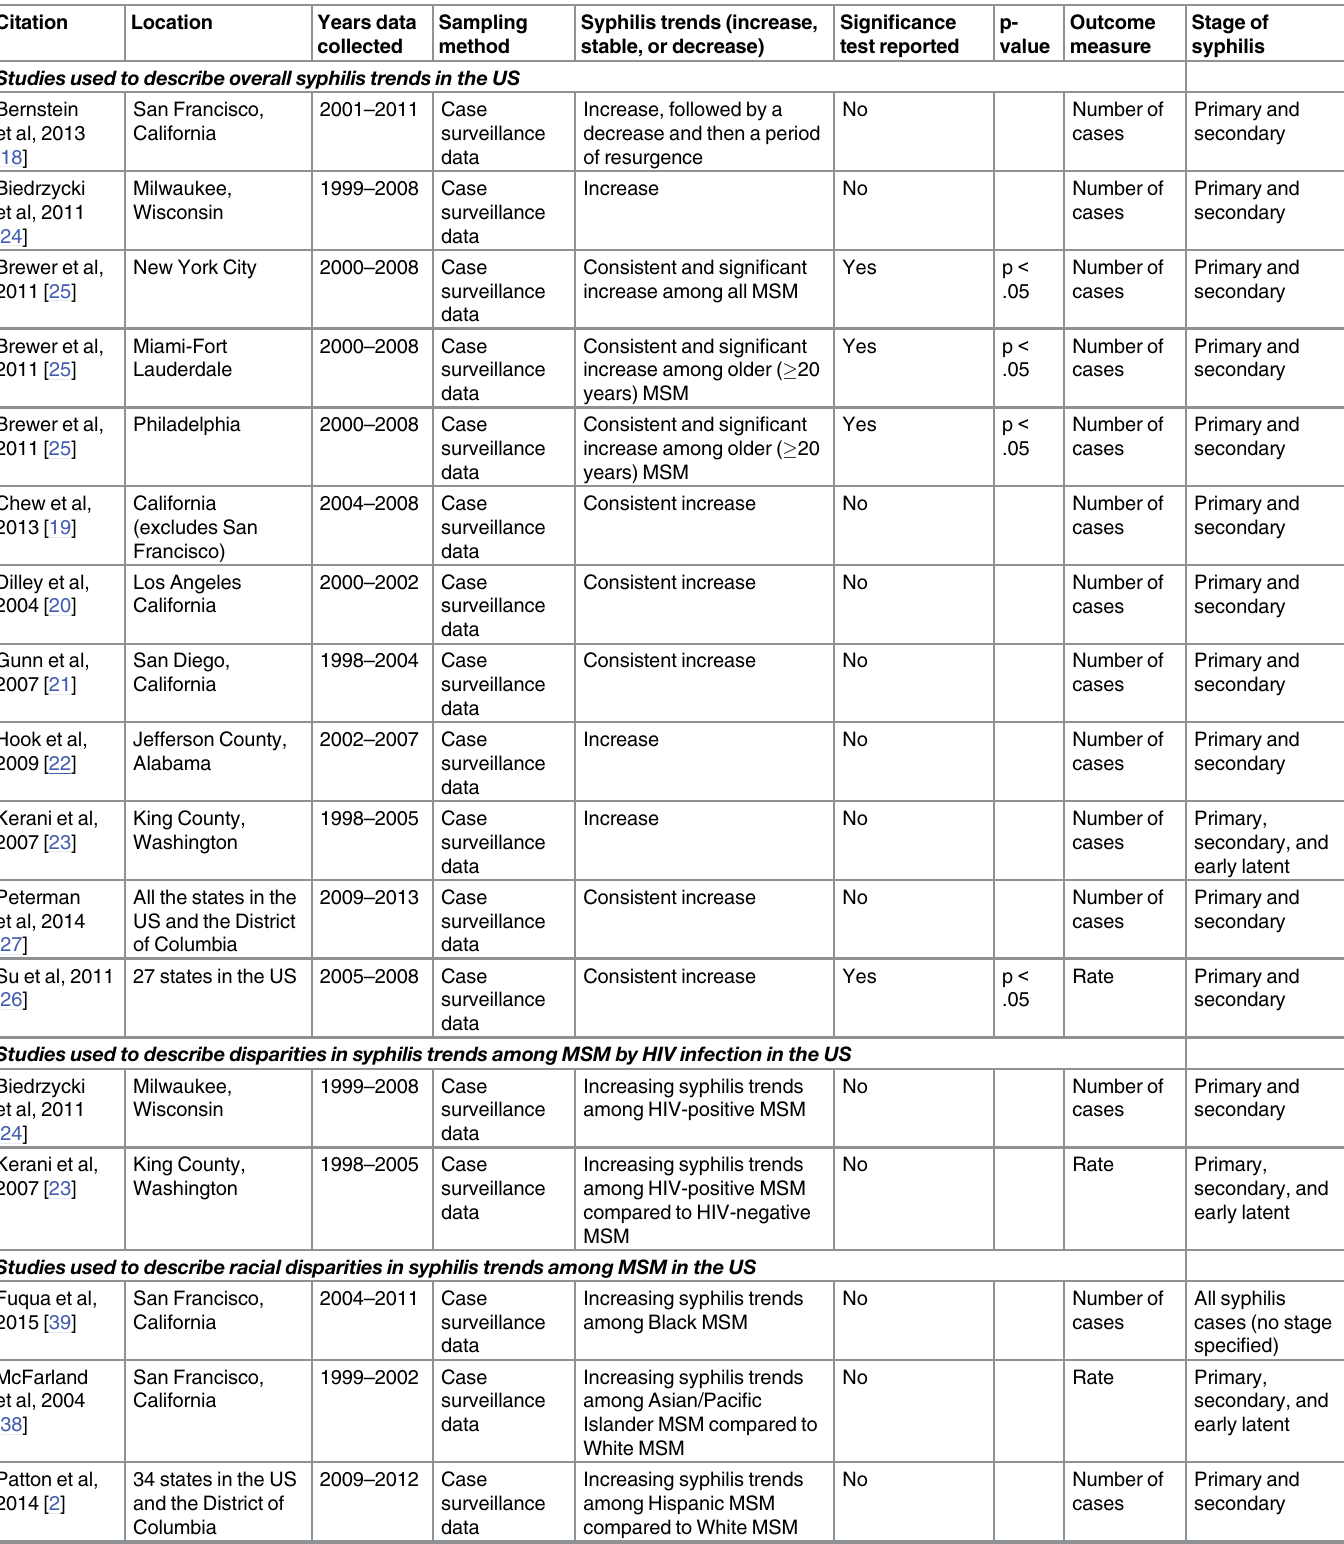
Table 1. Syphilis trend studies among MSM conducted in the United States, 2004 –